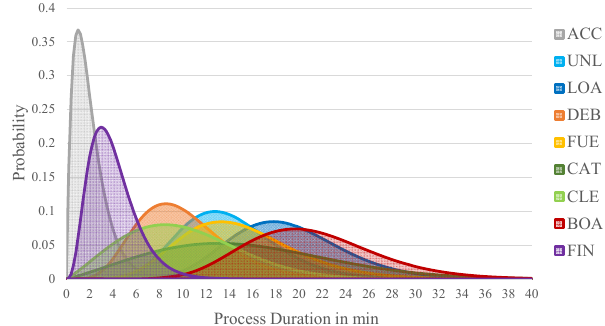
Fig. 2. Stochastic turnaround standard process